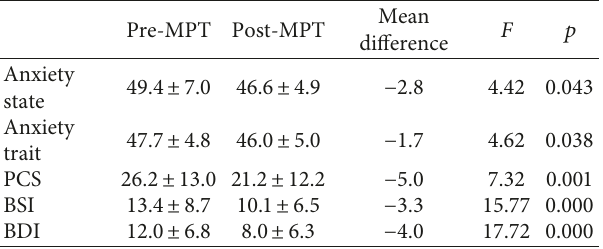
Table 2: Differences in psychological factors before and after